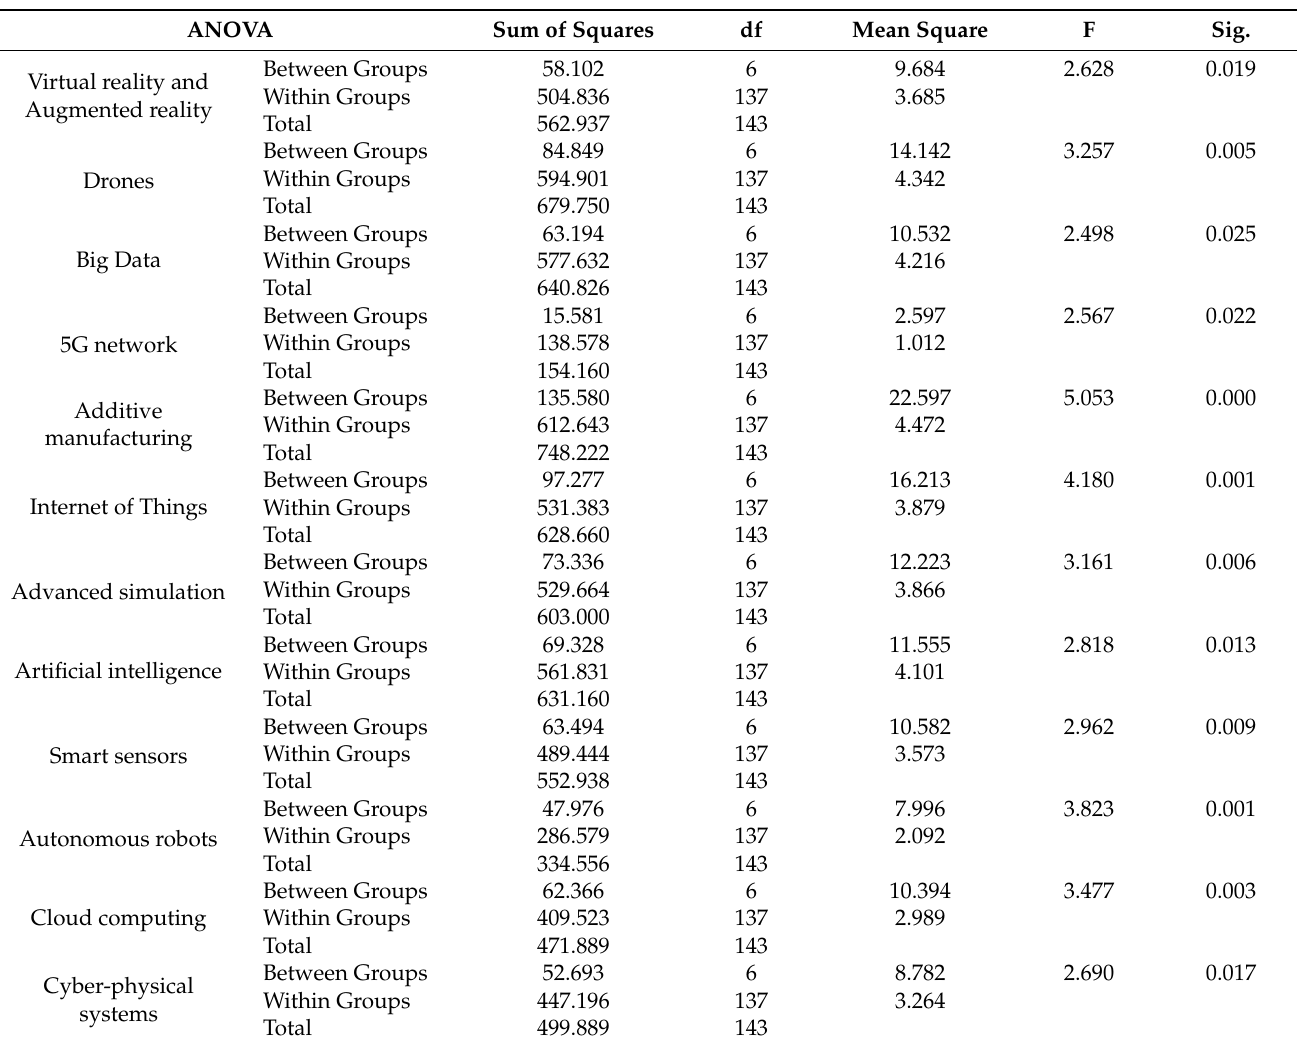
Table 7. Industry 4.0 technologies used in production